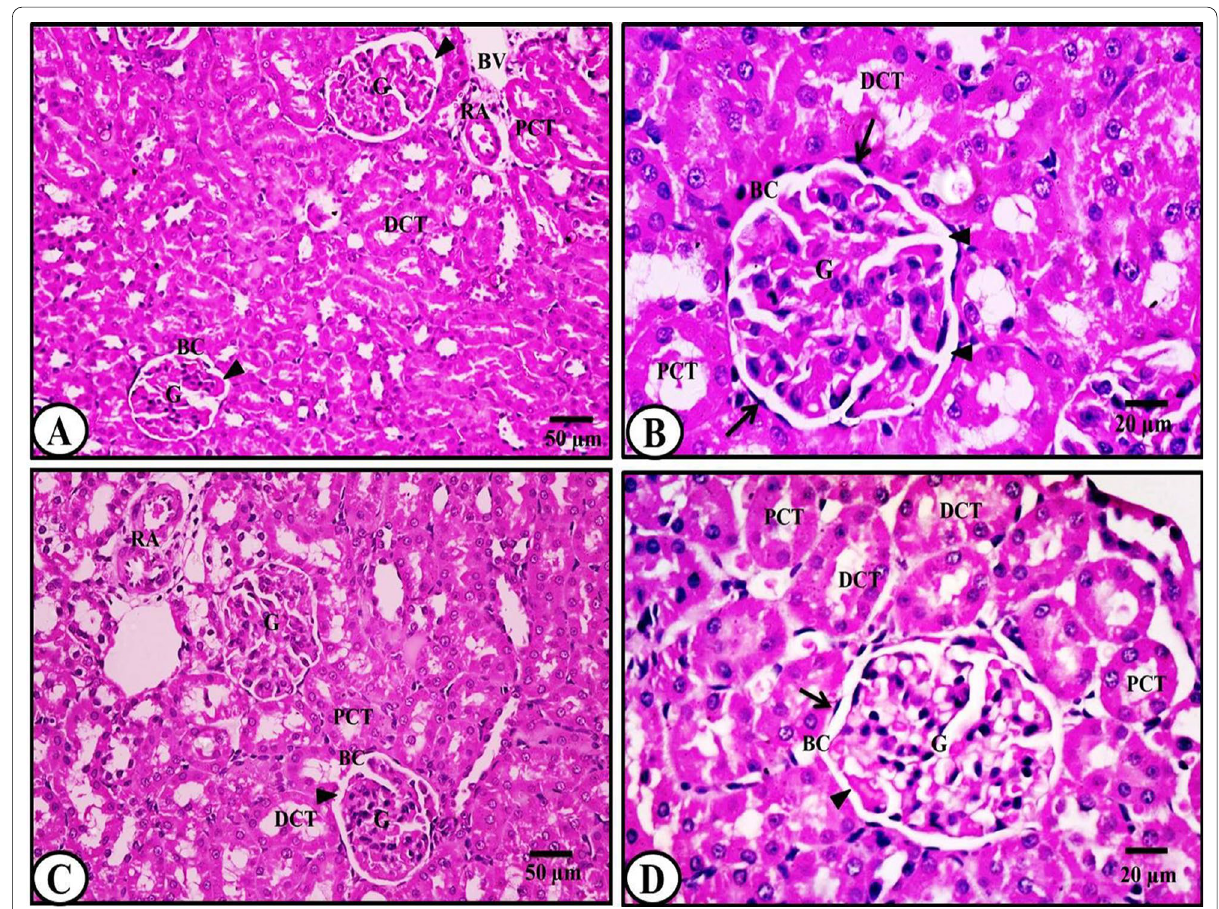
Fig. 2 Photomicrographs obtained from hematoxylin‑ and eosin‑stained kidney sections of ( A & B ) control rats and ( C & D ) HPE‑treated rats showing normal Malpighian corpuscles with Bowman’s capsules (BC) composed of squamous epithelium (arrows), Bowman’s spaces (arrowheads) and glomeruli (G), proximal (PCT) and distal (DCT) convoluted tubules lined with cuboidal epithelium, blood vessel (BV) and renal artery